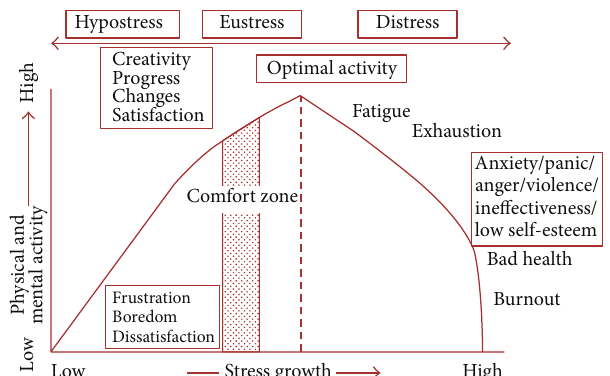
Figure 1: Human response to stress curve ( ∗ according to Nixon P: Practitioner 1979, Yerkes RM, Dodson